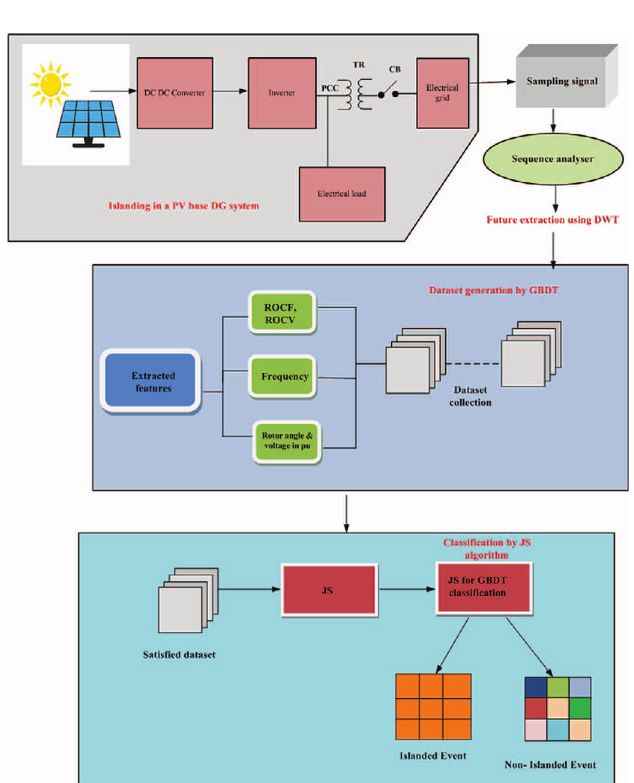
Fig. 3. Block diagram for presenting the process of proposed